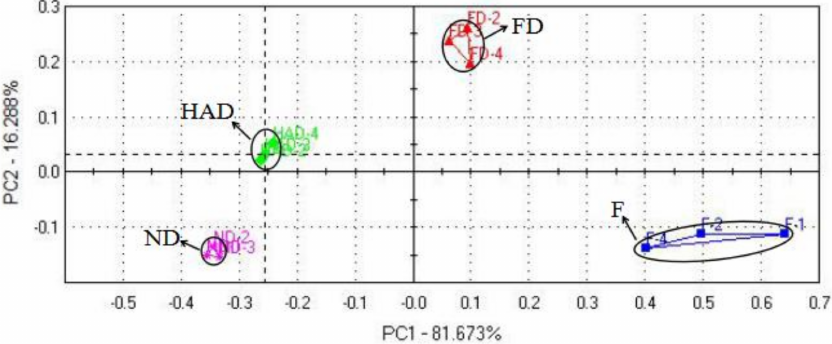
Figure 1. PCA of E-nose data for fresh and dried L. edodes ; F: fresh sample; FD: freeze drying sample; HAD: hot-air drying sample; ND: natural drying